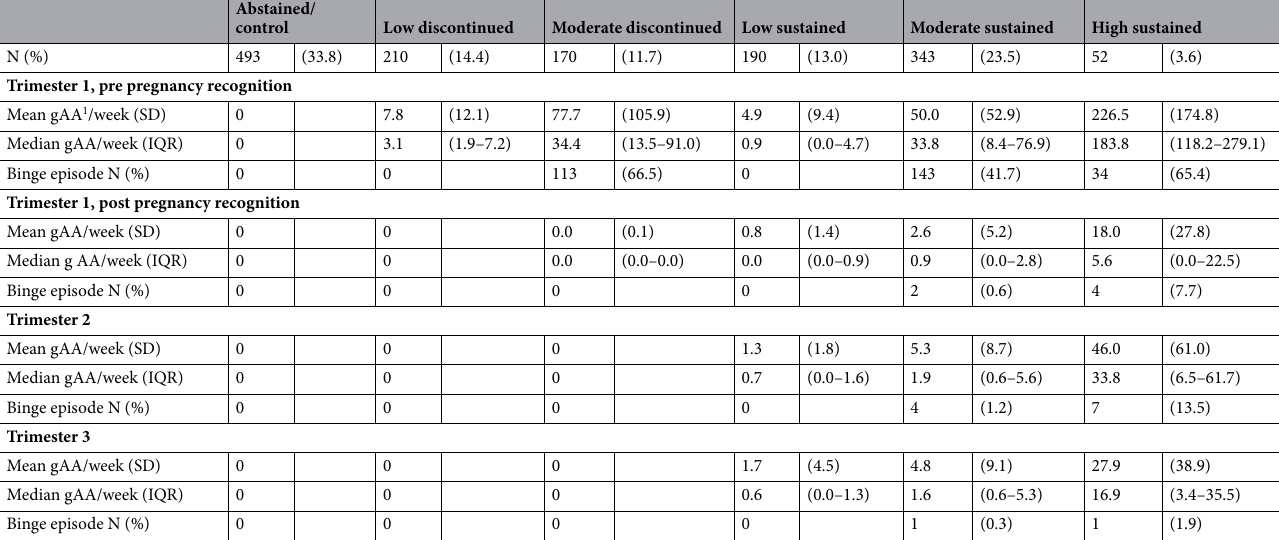
Table 2. Alcohol consumption characteristics by trajectory. 1 gAA: grams of absolute